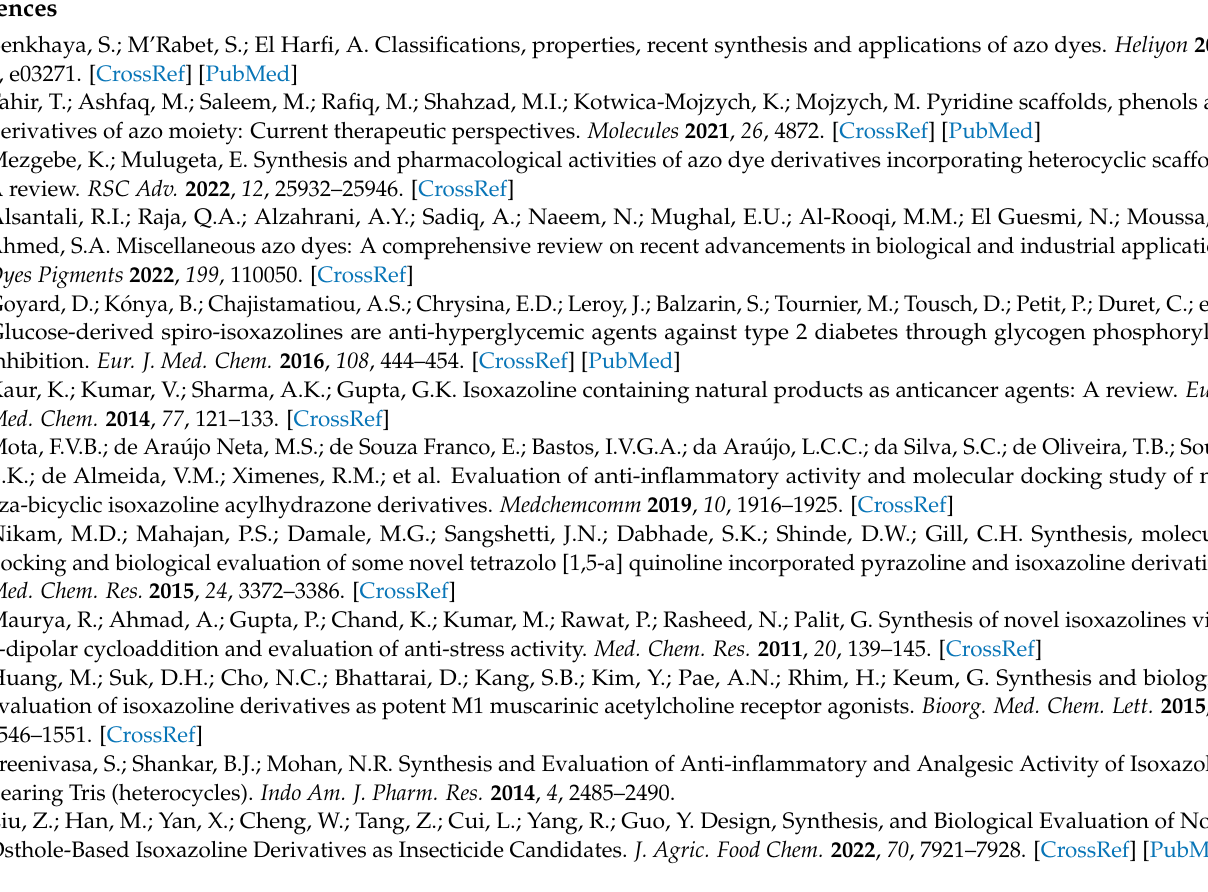
H NMR spectrum of 4a ; Figure S2: 13 C NMR spectrum of 4a ; Figure S3: 1 H NMR spectrum of 4b ; Figure S4: 13 C NMR spectrum of 4b ; Figure S5: 1 H NMR spectrum of 4c ; Figure S6: 13 C NMR spectrum of 4c ; Figure S7: HRMS spectrum of 4a ; Figure S8: HRMS spectrum of 4b ; Figure S9: HRMS spectrum of 4c